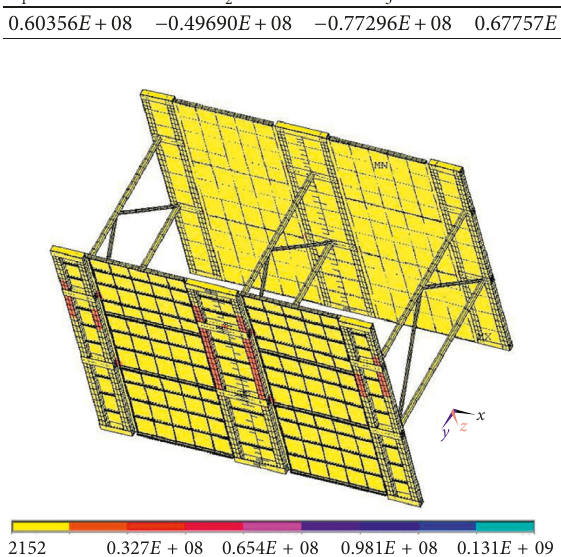
Figure 18: The von Mises stress nephogram of the column system (Pa).